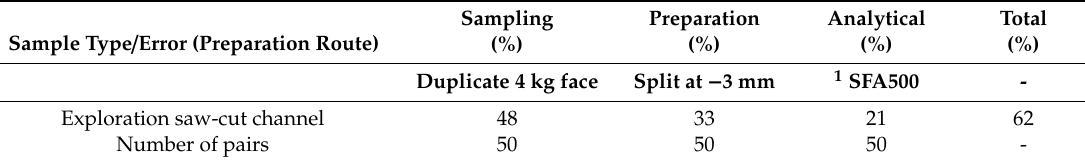
Table 31. Exploration face channel sample duplicate pair